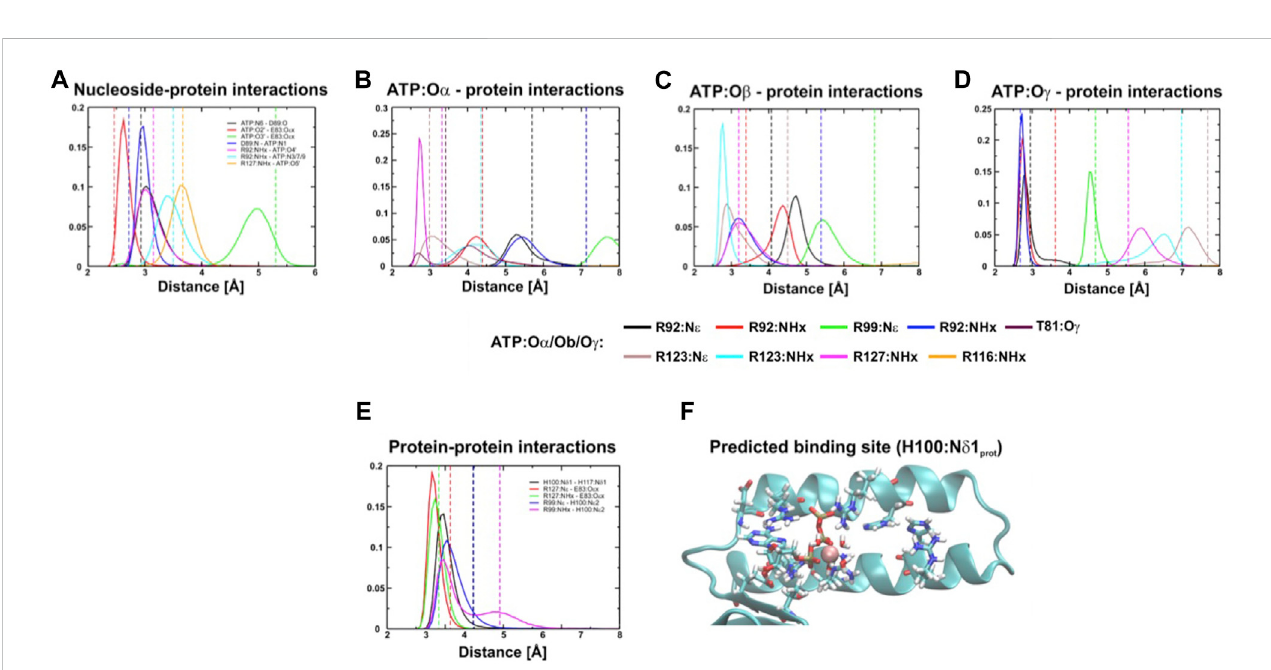
FIGURE 3 Distance distribution of interactions between the protein and ATP. (A – E) , Distance distribution of interactions within the binding site of the ε subunit ( ε H100:N δ 1 protonated) from C. thermarum during simulations. In (F) the predicted site is